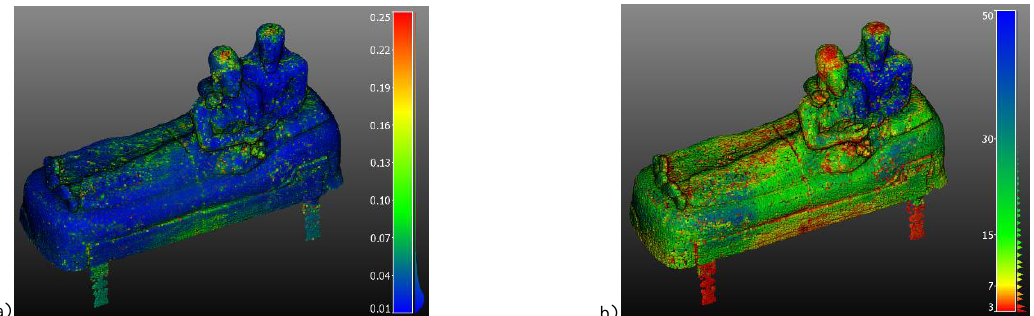
b) Figure 7. Colour-coded visualization of the filtered 3D tie points according to: a) precision vector length (mean = 0.057 mm, max = 1.265 mm); b) multiplicity, i.e. number of images where a 3D point is visibile (mean = 14, max = 98, min =